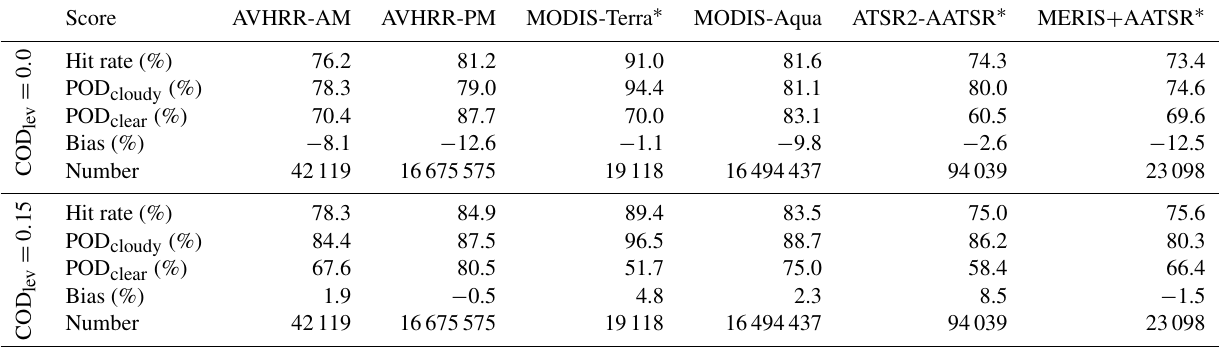
Figure 7. (a) Joint cloud property histogram, globally aggregated over all grid cells. (b) Global map of relative occurrence of cumulus clouds (according to ISCCP definition of Rossow and Schiffer, 1999 with CTP > 680hPa and COT < 3.6) with respect to all clouds. Data shown are from AVHRR-PM in June 2008. Table 6. Summary of cloud mask (CMA) validation results for Cloud_cci datasets when compared against CALIOP. Validation measures are the probabilities of detecting cloudy and clear scenes (Hit rate, POD liquid , POD ice ; see Appendix A for the definition of these terms) and bias. Also given is the number of collocated pixels. The scores are separated into two cloud optical thickness thresholds (COT thres ) representing above which CALIOP COT the CALIOP pixel was classified